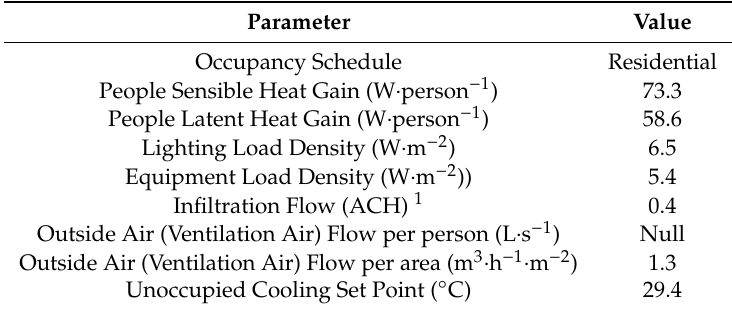
Table 1. Energy analysis parameters for multi-family occupant type.